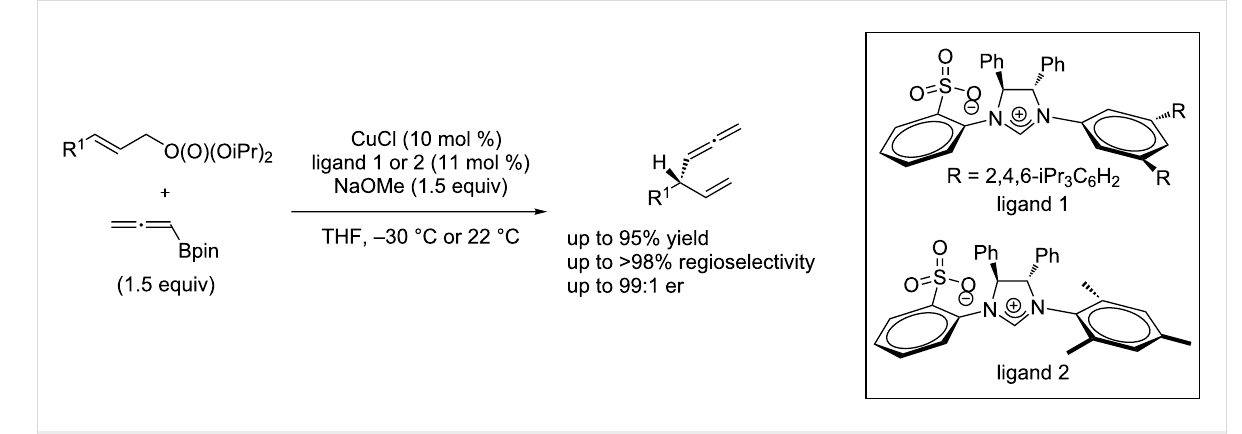
Scheme 26: Allylic substitution of allyl phosphates with allenylboronates.